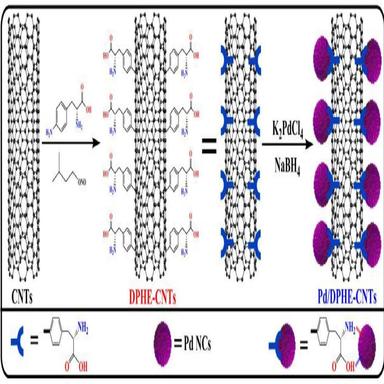
Illustration describing the synthesis of Pd/CNTs-DPHE.